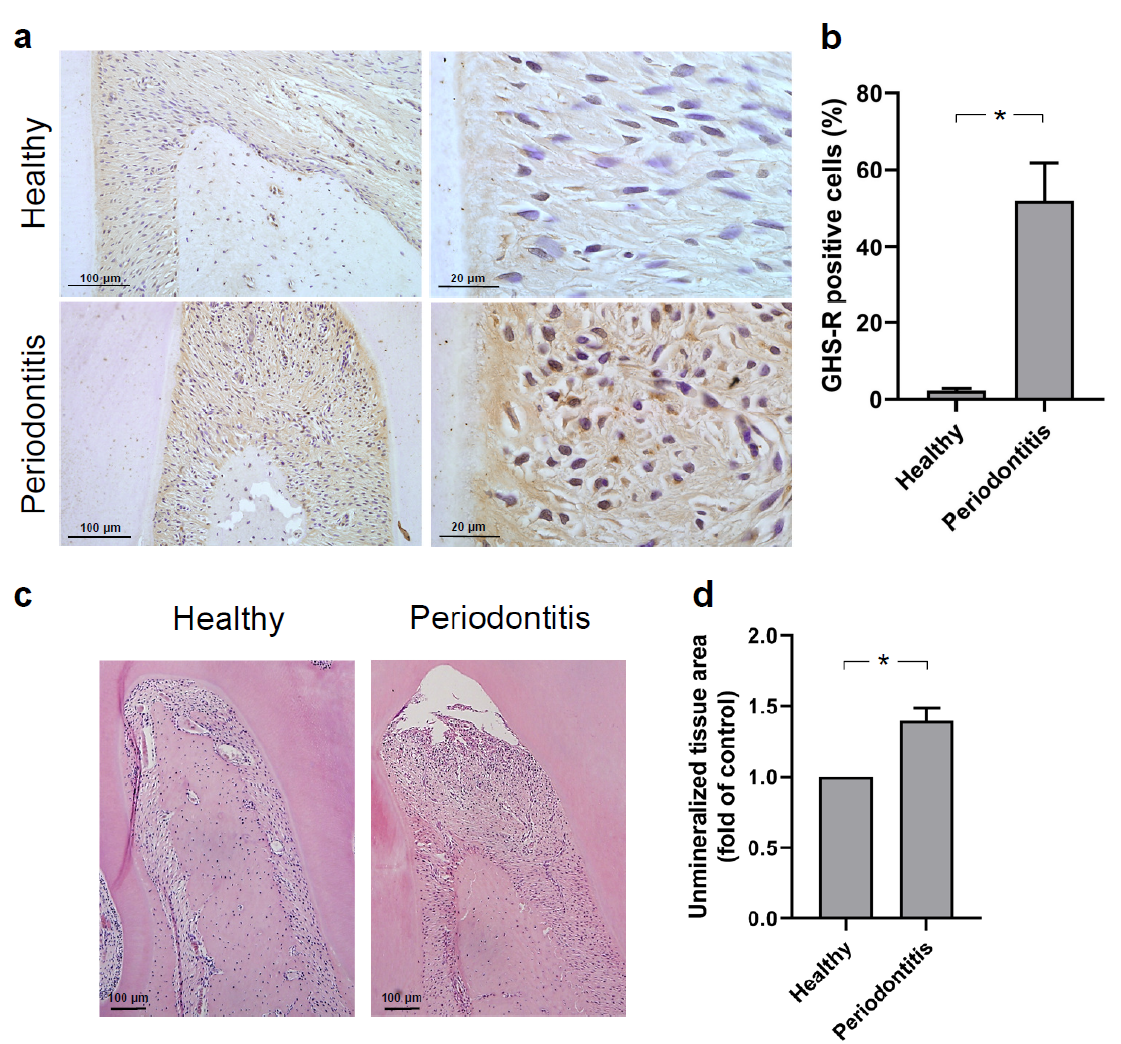
Figure 1. ( a ) GHS-R protein in periodontium of first molars of rats from healthy control and periodontitis groups, as evaluated by immunohistochemistry. Representative images of histological sections from one healthy control animal and one animal with periodontitis are shown. ( b ) Percentage of GHS-R positive cells is depicted. Results are expressed as mean ± SEM (n = 4 rats/group). ( c ) Representative histological sections stained with hematoxylin and eosin (H&E) and ( d ) comparison of unmineralized tissue area measured in the furcation region of first maxillary molars of rats from healthy control and periodontitis groups presented in fold change to control. Results are expressed as mean ± SEM (n = 4 rats/group). * Significant ( p < 0.05) difference between groups.